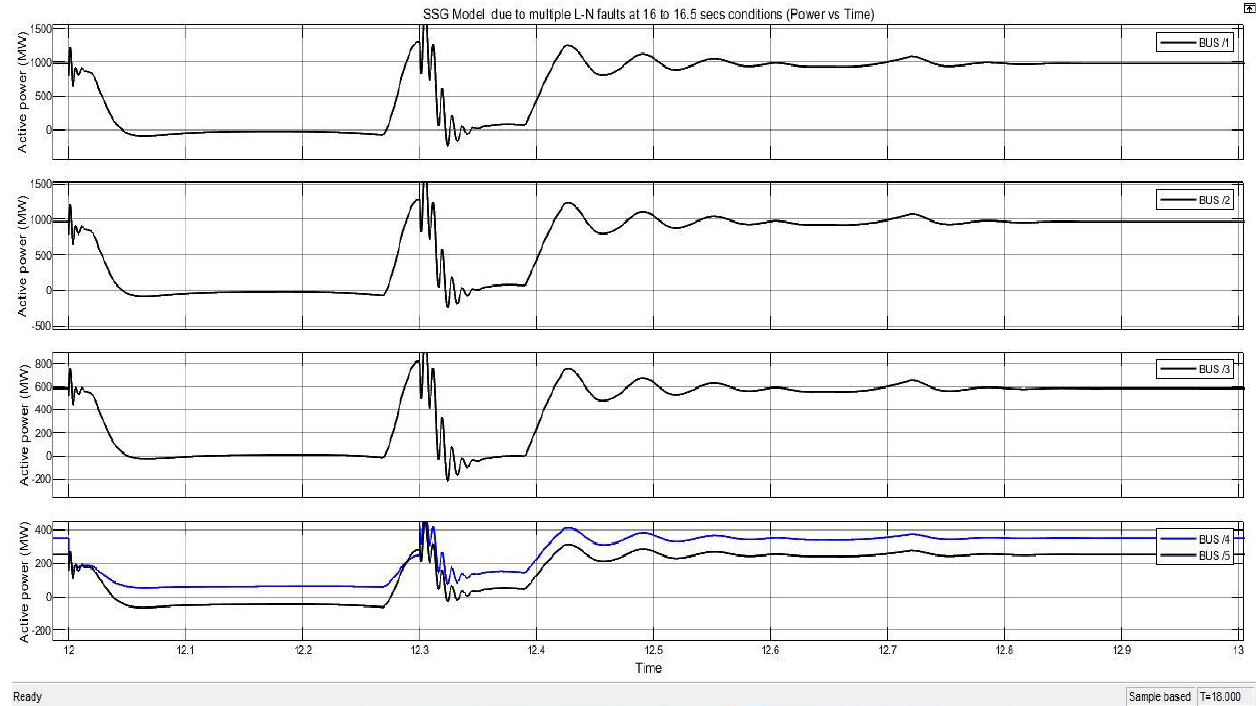
Figure 23. Multiple double line-to-line (L-L) faults are inserted in the system from 12 to 12.3 s (Bus 1 to Bus 5).